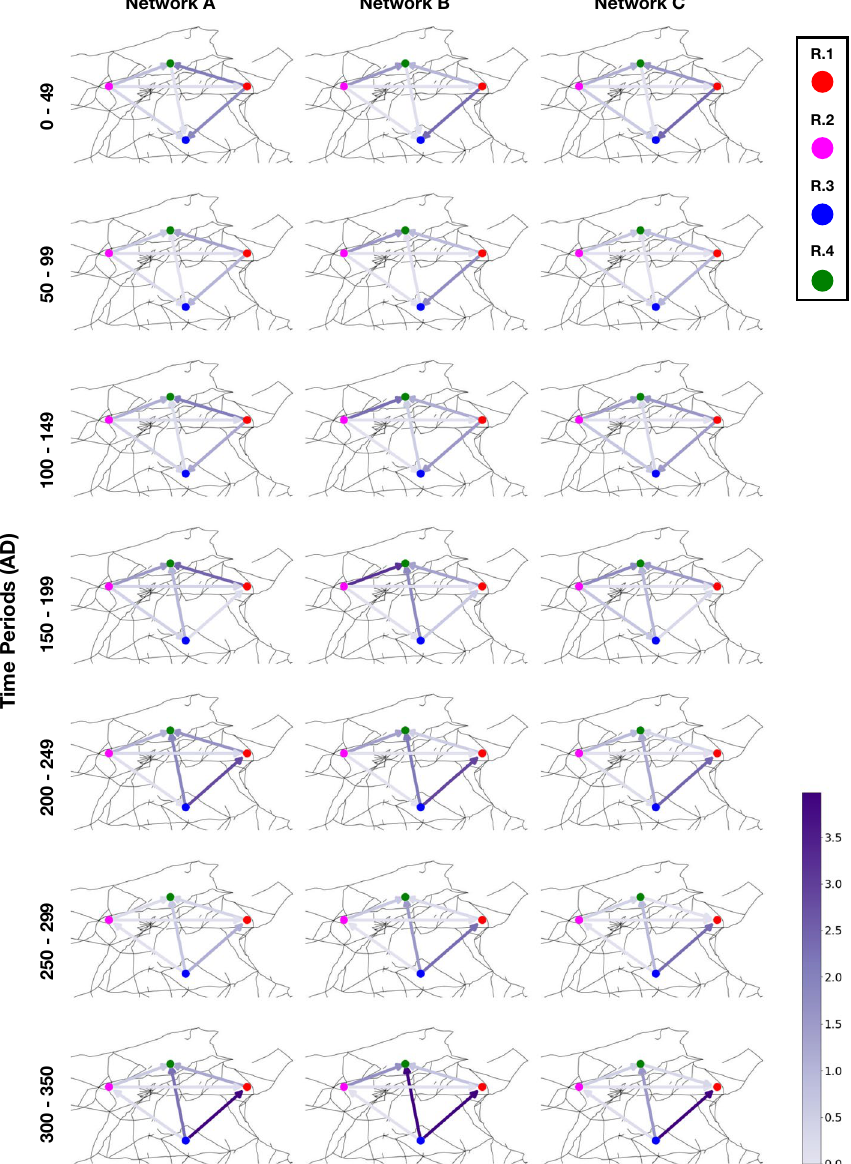
Fig. 4 Temporal change of the effective current H ∗ ( t ) . Network edges are colored according to the value of the effective current H ∗ ( t ) and the arrows point in the direction of positive current. Nodes are colored according to the original region color distribution. Sources Ancient World Mapping Center (2012); iDAI. geoserver German Archaeological Institute (2022). Licensed under CC BY-NC 3.0. and Open Data